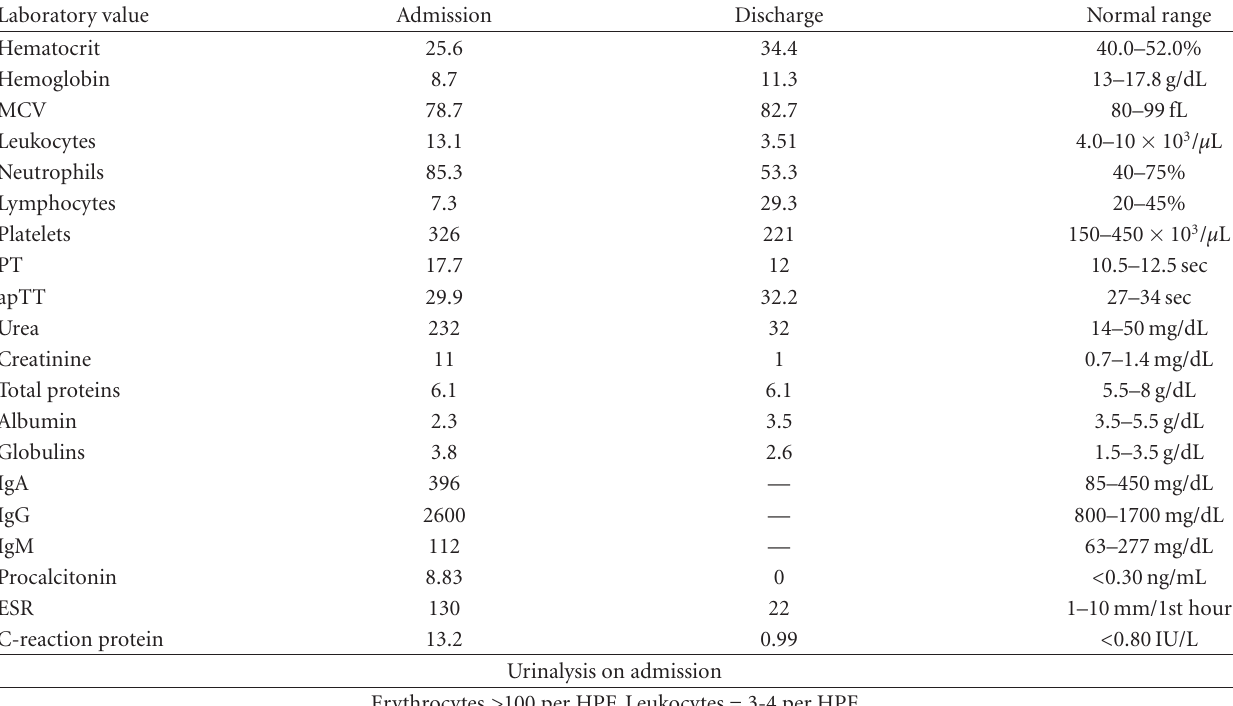
Table 1: Laboratory findings of our patient at presentation and on discharge.